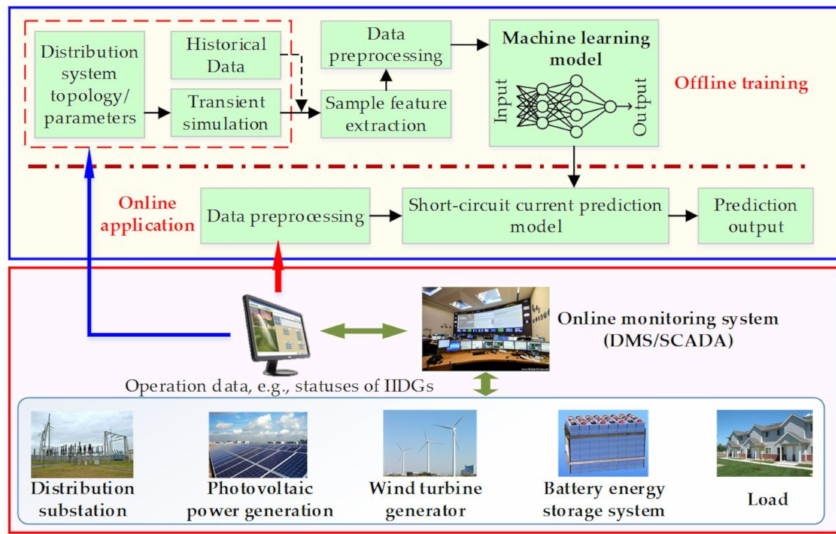
Figure 1. Overall framework of the proposed